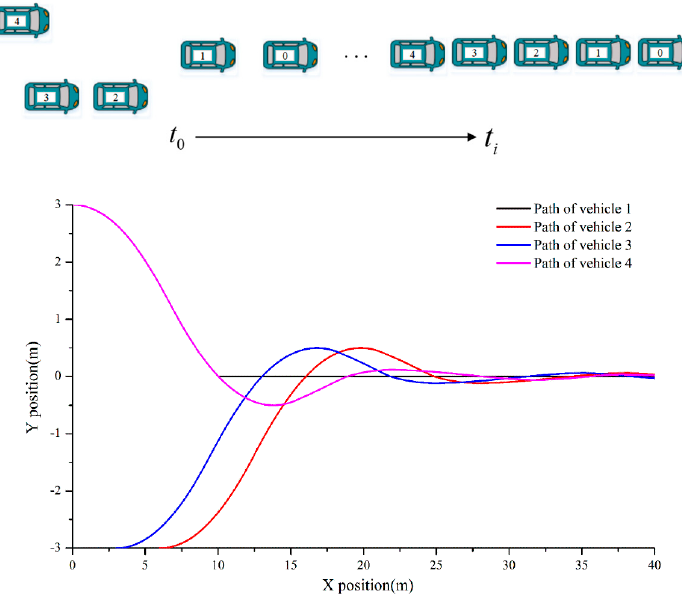
Figure 15. Vehicle path in platoon merging.